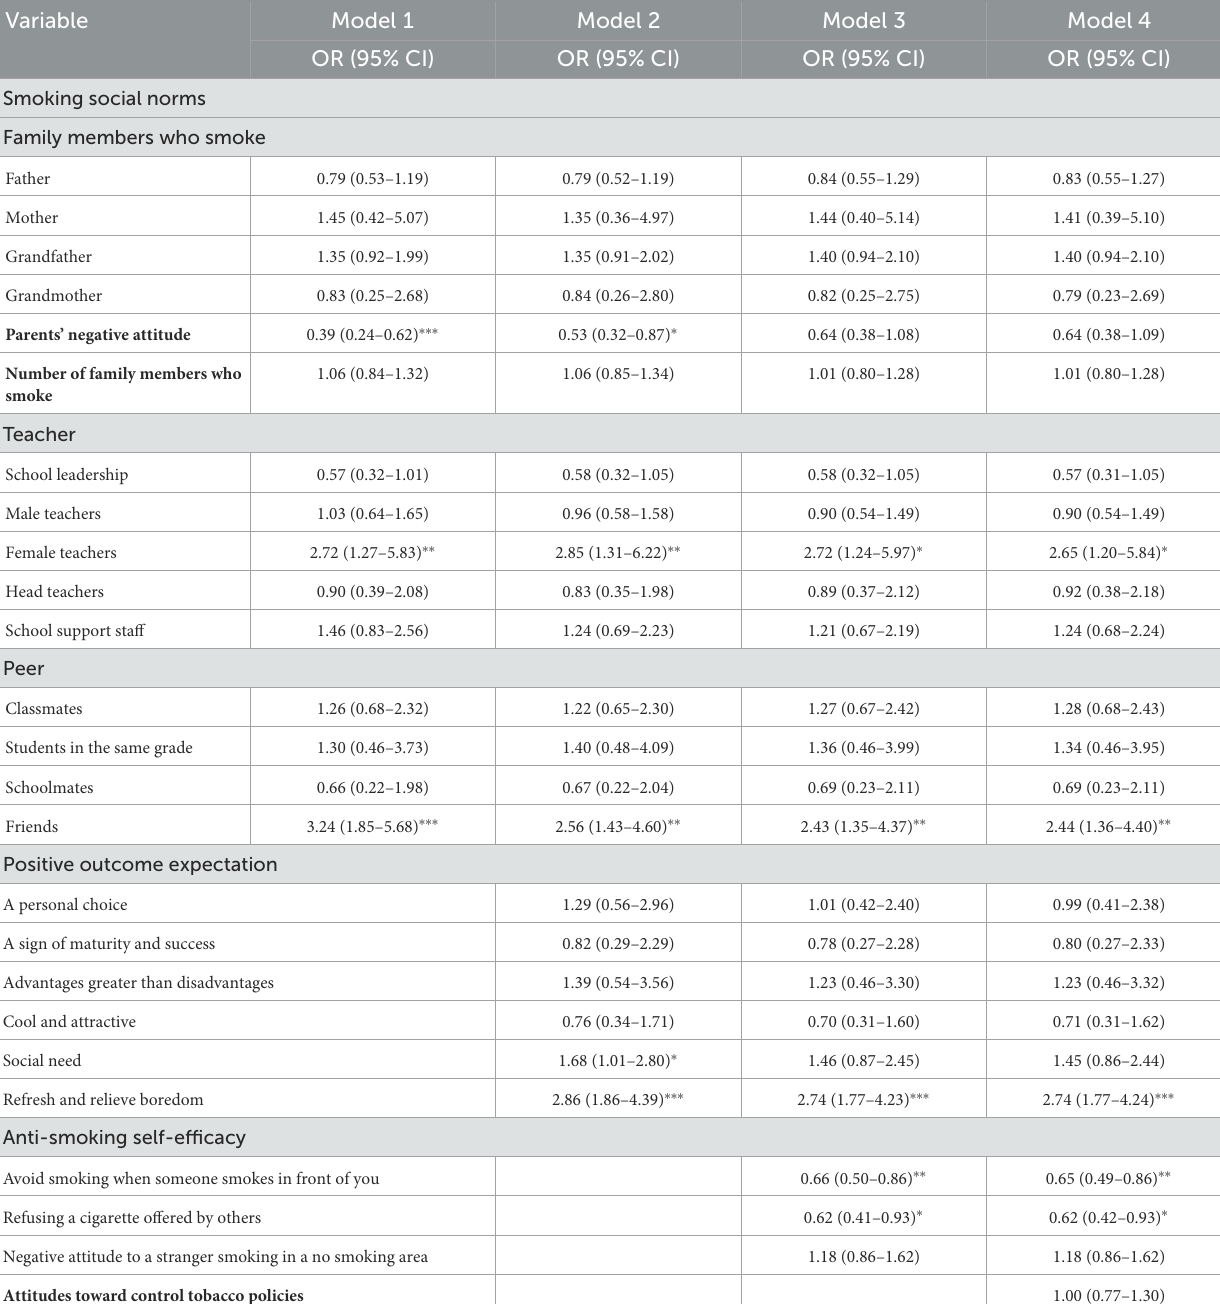
TABLE 2 The influence of smoking social norms, positive outcome expectations, anti-smoking self-efficacy and attitudes toward control tobacco policies on adolescents’ smoking behaviors (experimental smoking vs.